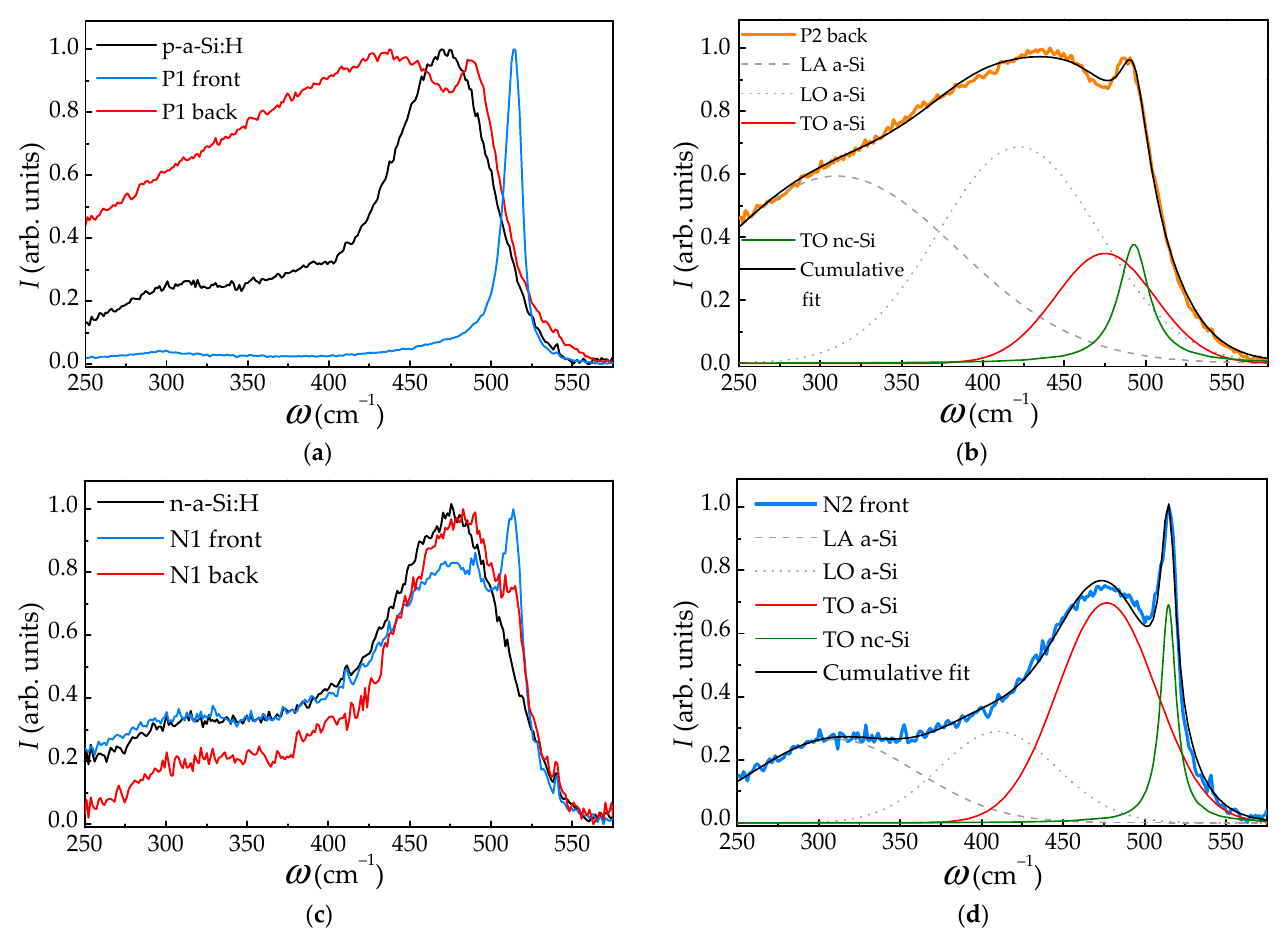
Figure 6. ( a ) Typical Raman spectra for the initial p-a-Si film and irradiated region P1. ( b ) Decomposition of the Raman spectrum obtained from the back of the sample P2. ( c ) Typical Raman spectra for the initial n-a-Si film and irradiated region N1. ( d ) Decomposition of the Raman spectrum for the front of the sample N2. All spectra are normalized by maximum intensity. Table 2. Silicon nanocrystals size and the nc-Si phase volume fraction within the modified samples.